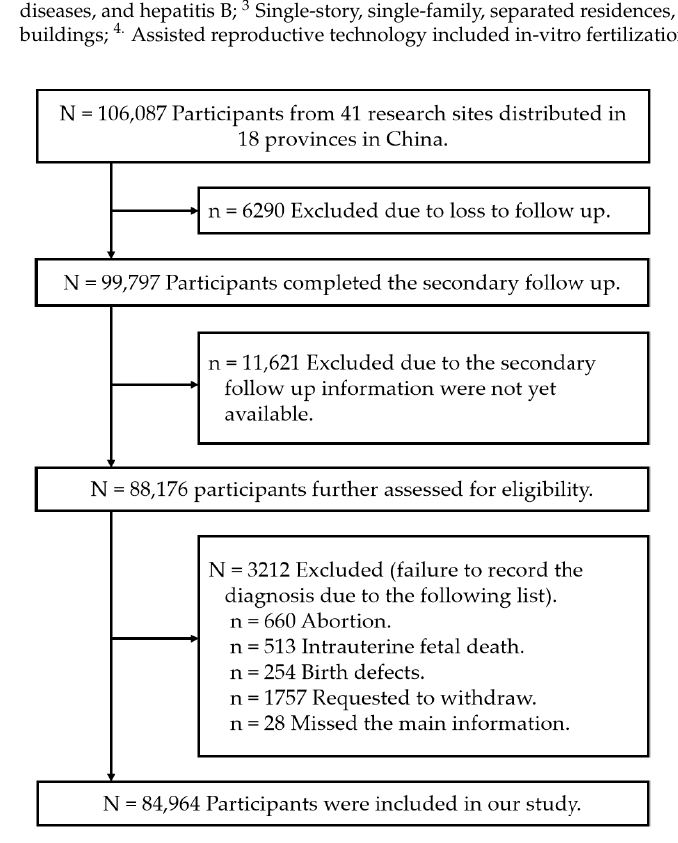
Figure 1. Flowchart of study enrolment, with the participants selected from 41 research sites distributed in 18 provinces or municipalities during November 2017 to December 2020 (n = 84,964). Table 1. Characteristics of study participants (n = 84,964).